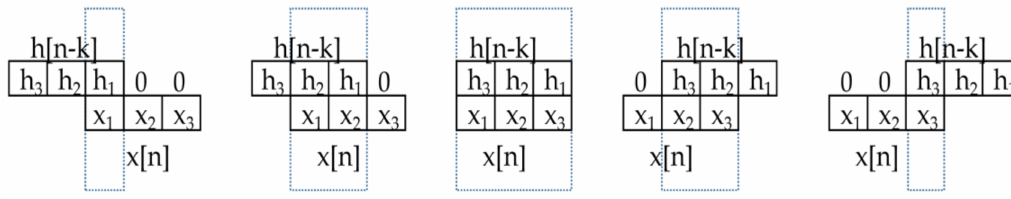
Figure 3. One-dimensional convolution